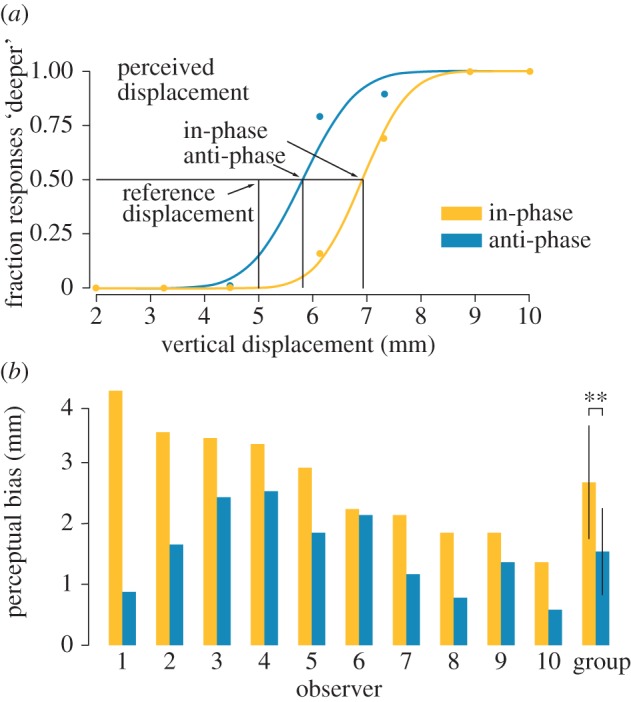
Results of experiment 3. (a) Psychometric curves of a representative observer with a 5 mm reference displacement of the surface. The point at which the curve ordinates are equal to 0.5 corresponds to the same perceived displacement of the platform with and without skin stimulation. (b) The points of subjective equivalence (same perceived displacement) for n = 10 observers with group average and standard deviation. (Online version in colour.)